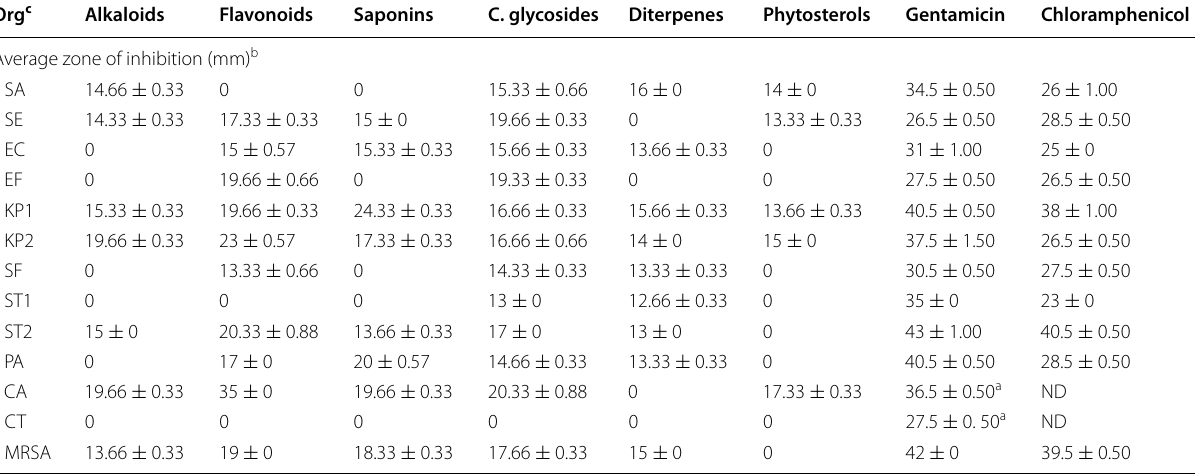
ND not done a Amphotericin B b Values are expressed as Mean